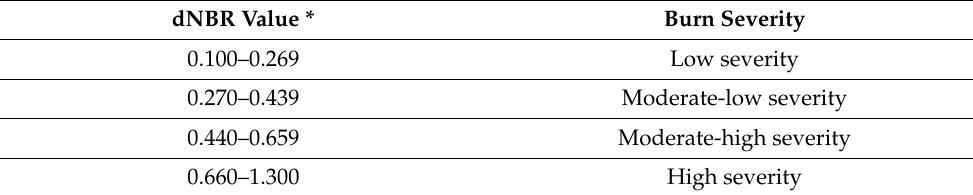
Table 3. Burn severity classification according to dNBR values